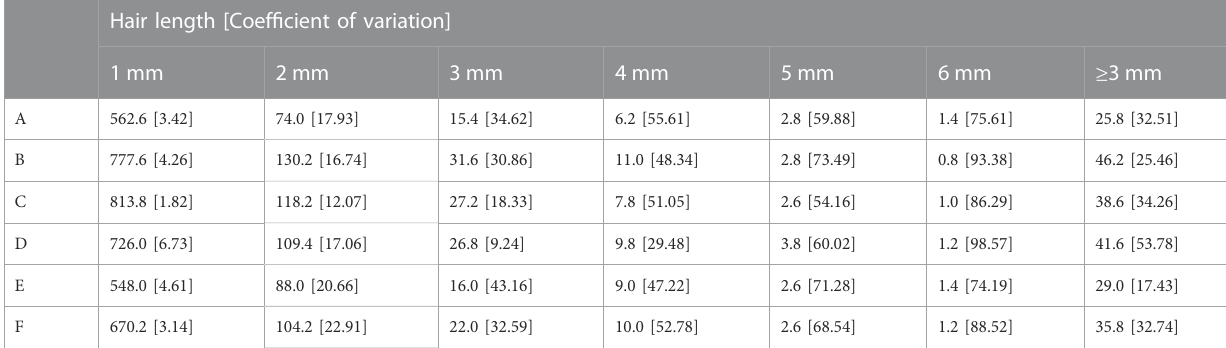
TABLE 2 Hair number comparison of different composite